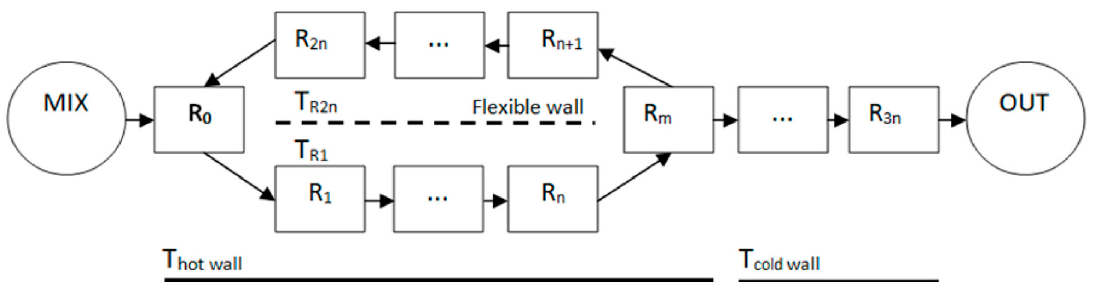
Figure 3. Reactor network schematic, with recirculation.